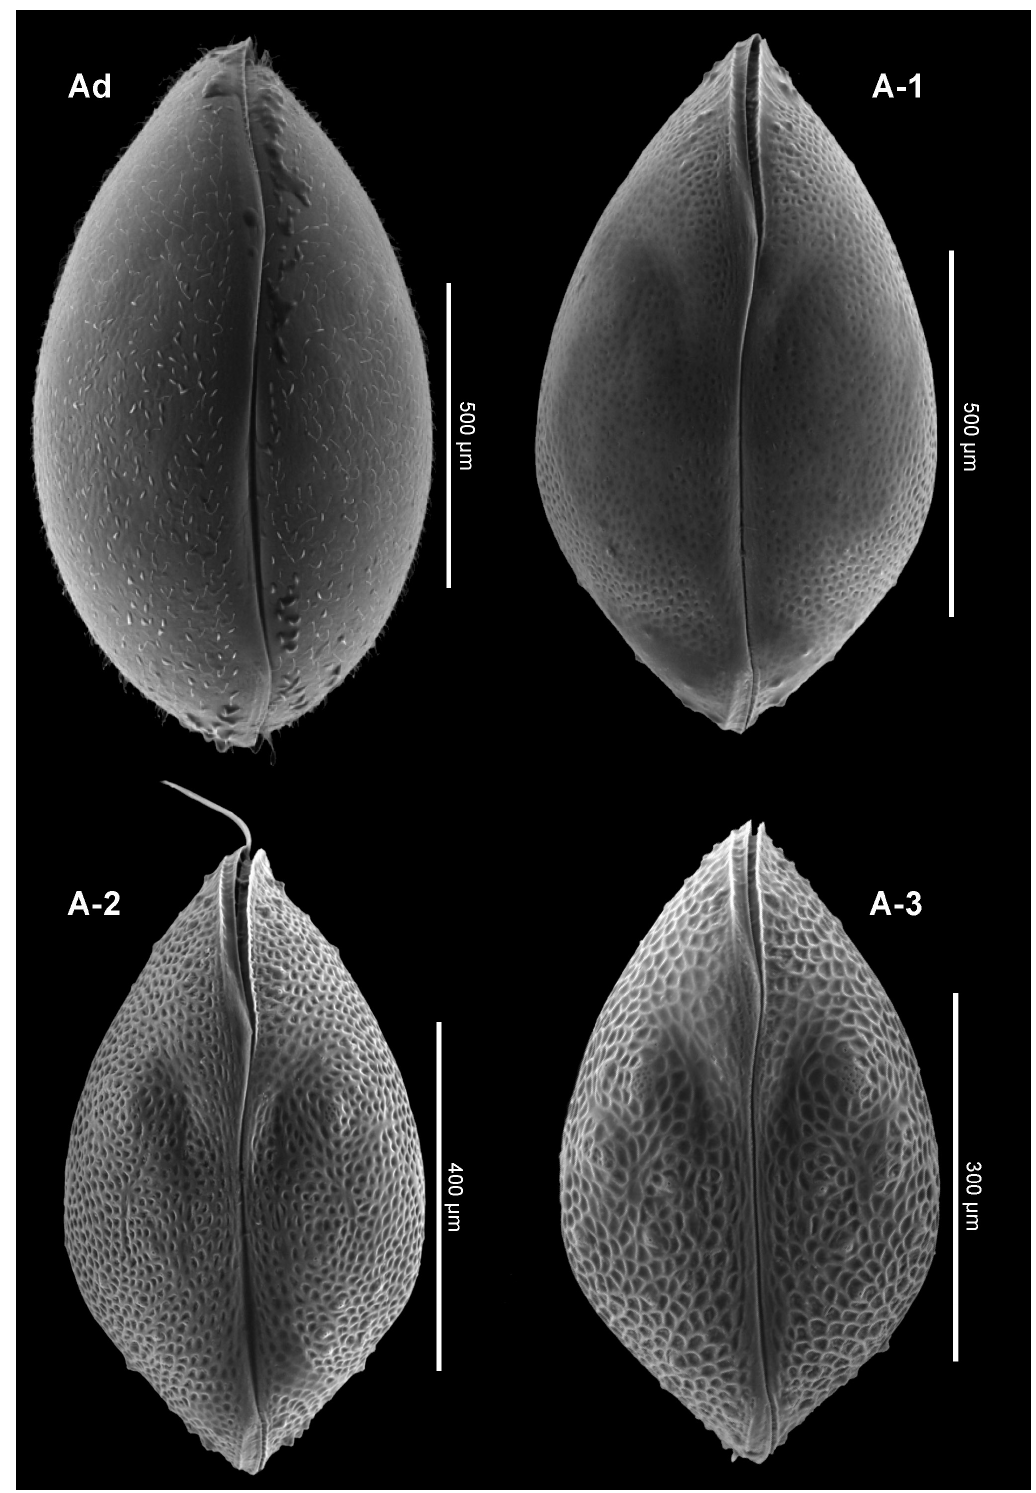
Fig. 17. Dorsal views of carapaces of Bennelongia cf. barangaroo nov. sp. from McNeil Claypan. Observe the coarse reticulation in A-3 specimens and the pseudo-punctuation that becomes less visible with progressing ontogeny. The adult specimen in top left image displays some agglomeration of glue along the hinge, particularly in the anterior and posterior